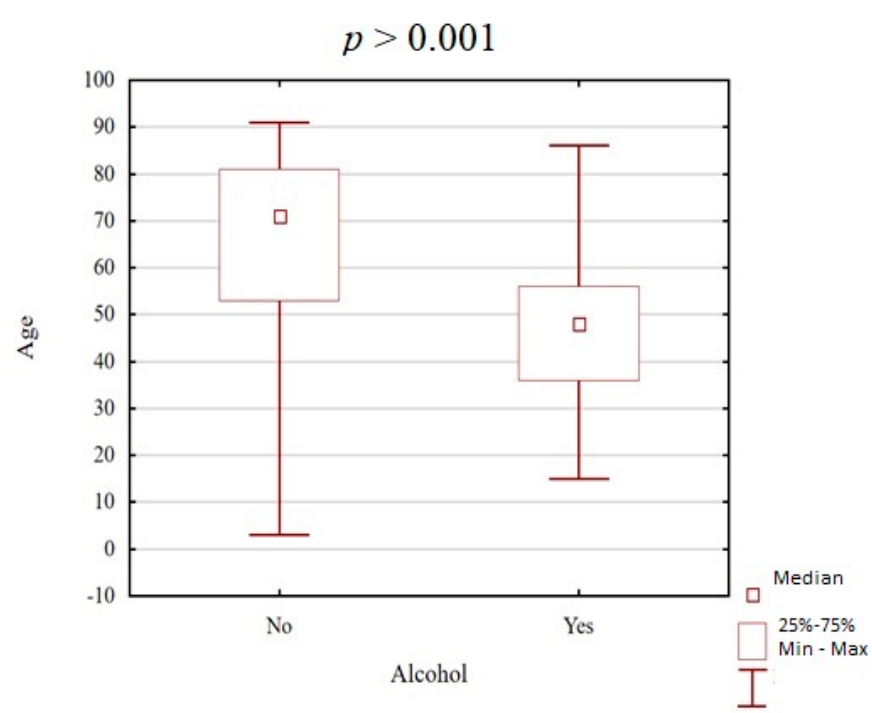
Figure 1. Analysis of the relationship between the age of the victims and the presence of ethyl alcohol in their systems.